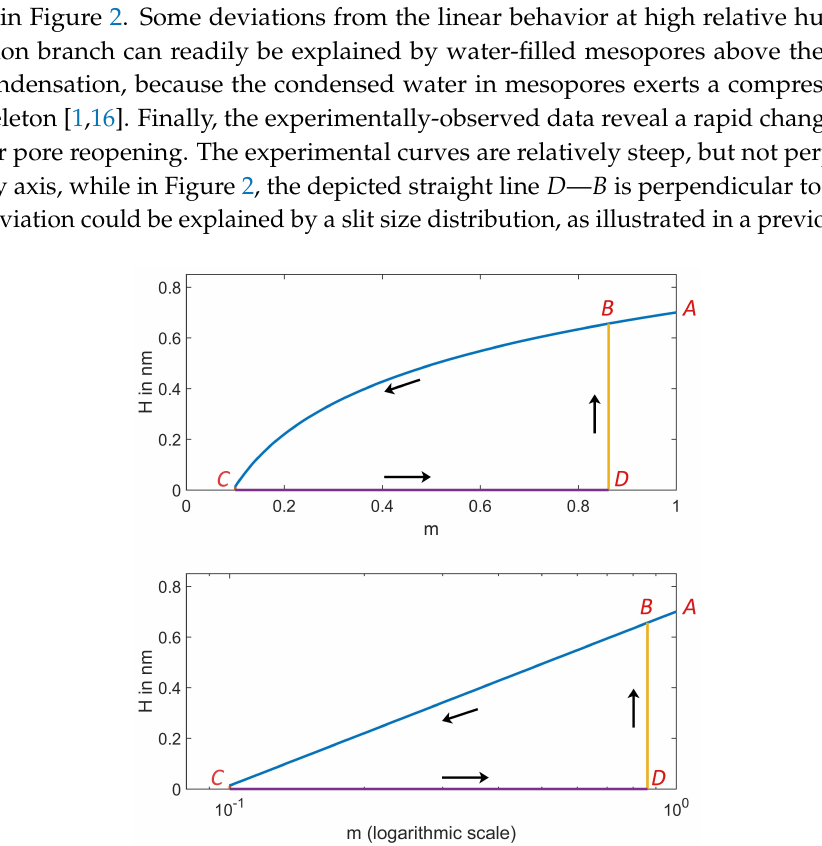
Figure 2. Thickness of a circular slit filled with water ( H 0 = 0.7 nm, R = 5 nm) embedded in a soft solid ( E = 5 GPa, ν = 0.33, w = 0.1 N/m, q = 1, T = 300 K) evaluated by using Equation